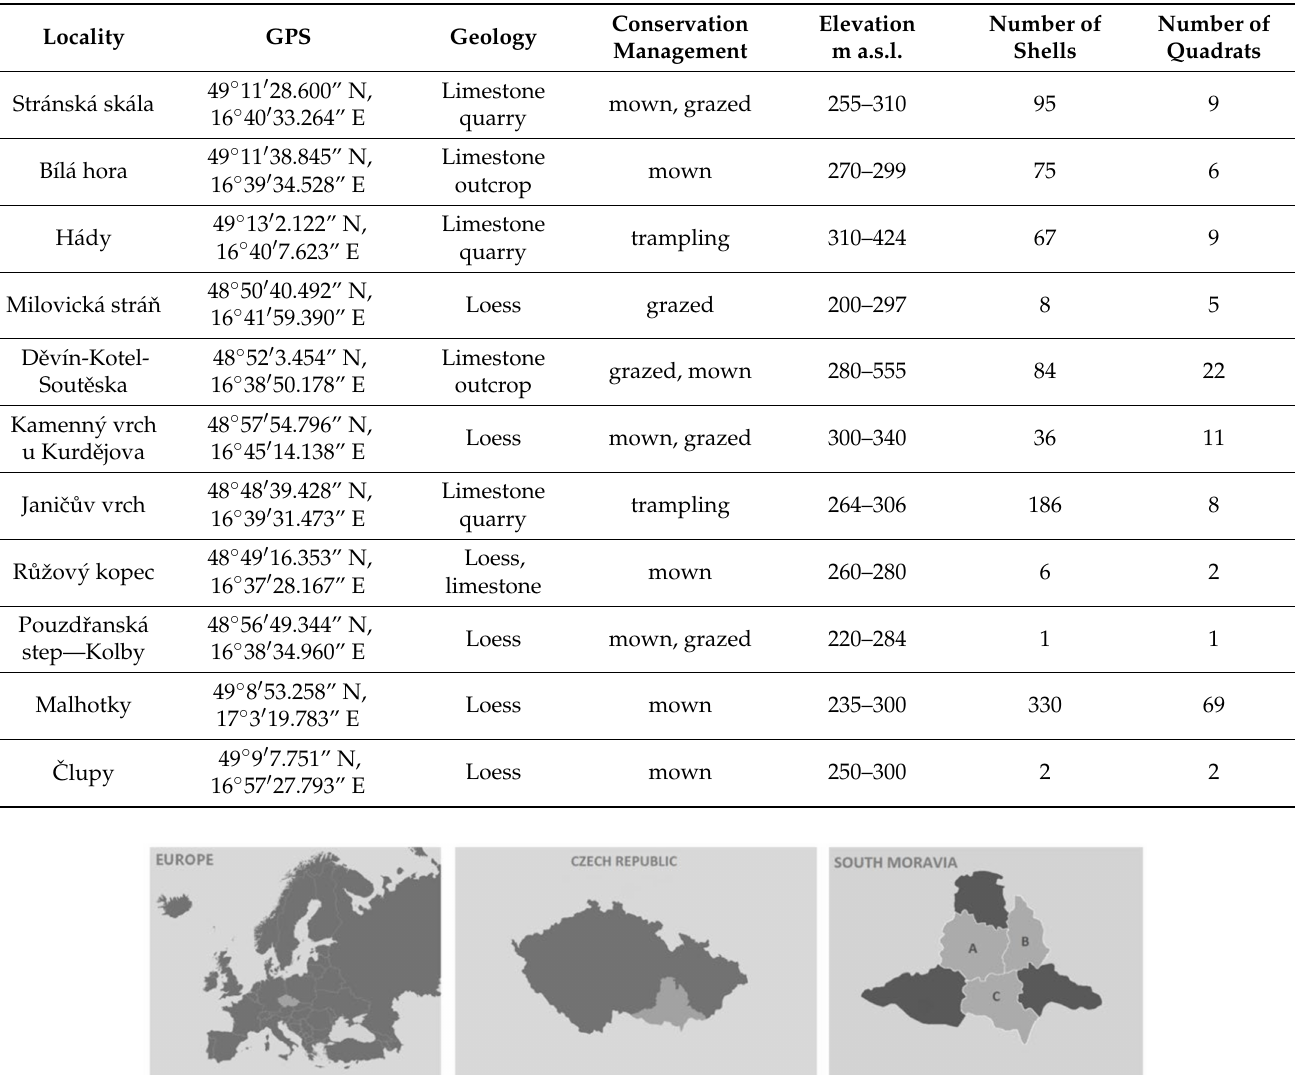
Table 1. Information about visited localities.